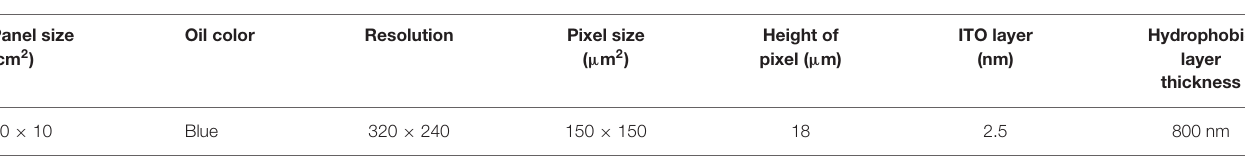
TABLE 1 | Parameters of the EWD